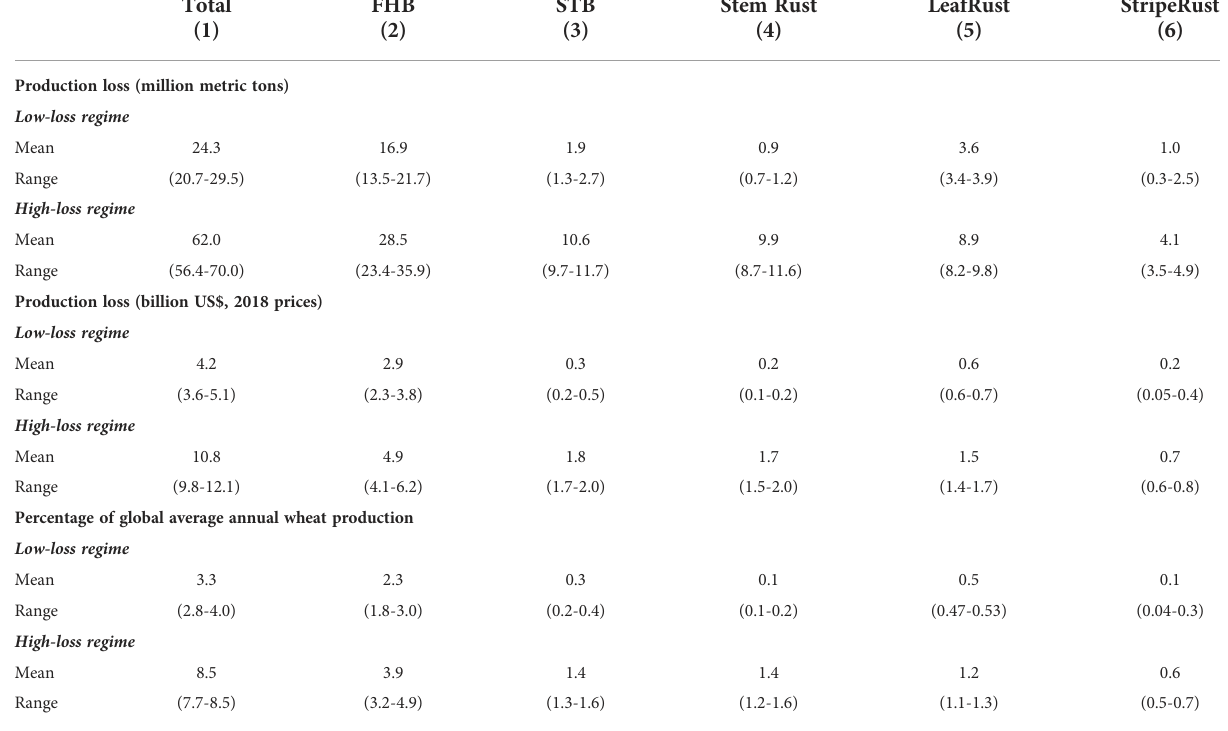
TABLE 2 Estimates of global annual losses in wheat production from fungal